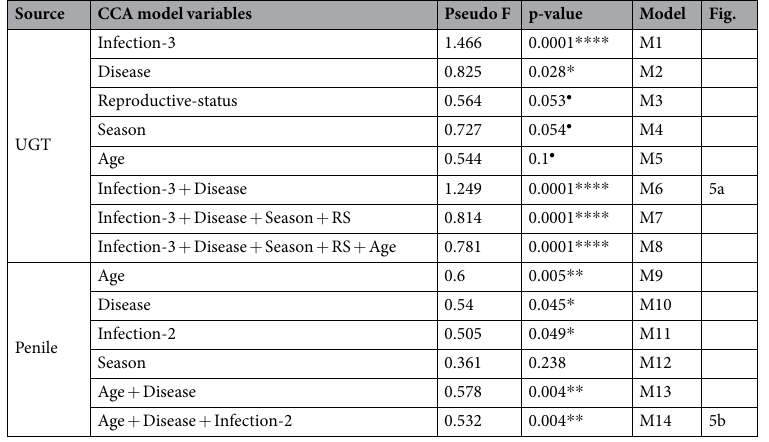
Table 2. Models for Canonical Correspondence Analysis of microbiota OTUs for UGT and penile sites. p-value: • 0.1–0.05, * < 0.05, ** < 0.01, *** < 0.001, **** < 0.0001.